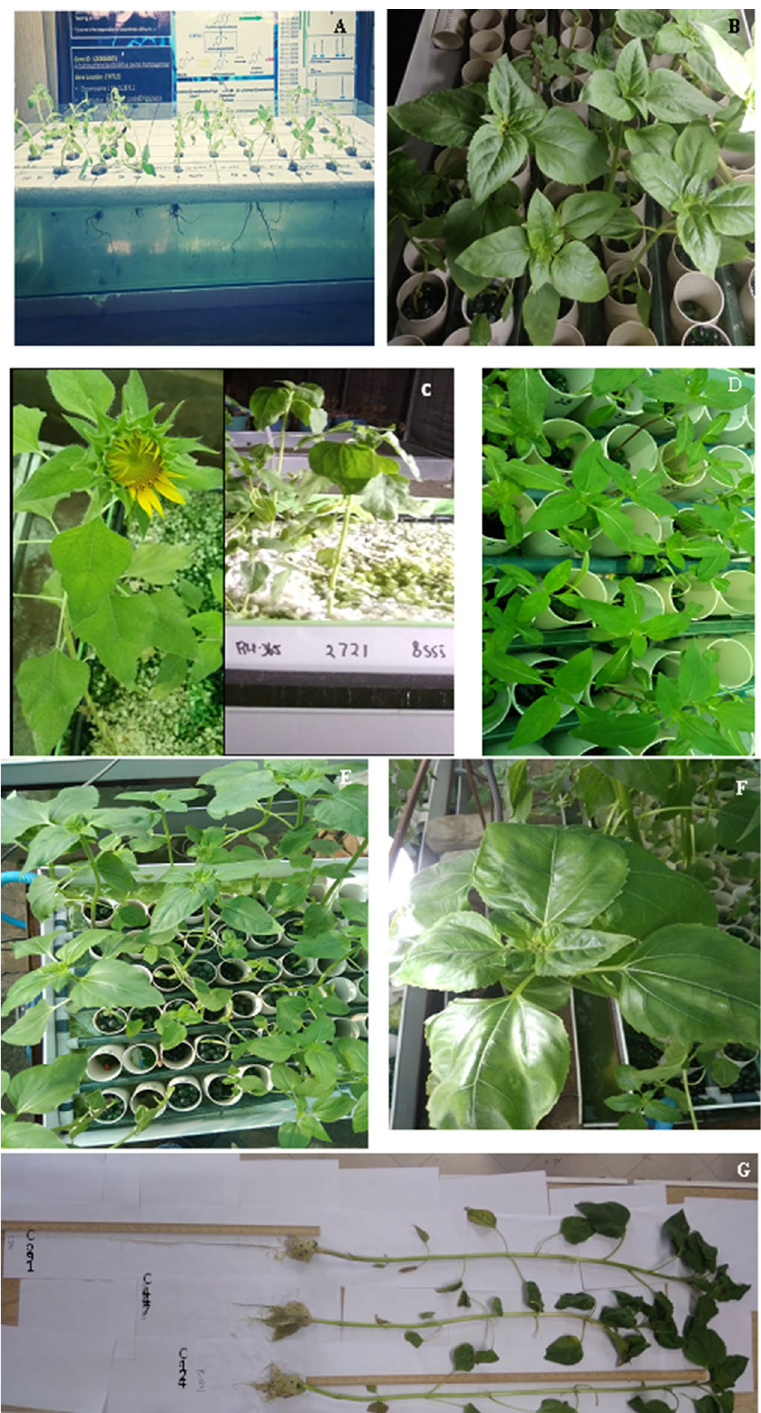
Figure 1. ( A ) Hydroponic platform with roots directly submerged in nutrient media aerated with airstone (HP1) after seedling transplant (15 days after initiation of trial). ( B ) Highly vigrous growth of sunflower ( Helianthus annuus L.) in two pan hydroponic platform abbreviated as HP3. ( C ) Hydroponic platform HP2 (plant anchored in gravel) contaminated by algal growth (30 days after initiation of trial) and anthesis (65 days after initiation of trial). ( D ) Helianthus annuus accessions treated with high temperature in HP3 (Hydroponic platform in which plants anchored in glass ball (8 mm diameter). ( E ) A view of two pan hydroponic platform (HP3) sunflower accessions grown under osmotic stress. ( F ) Plant with disc floret showing the plants approaching their reproductive growth phase. ( G ) Differences among accession for root length i.e. C-291 reaching the root length of more than 1 m in